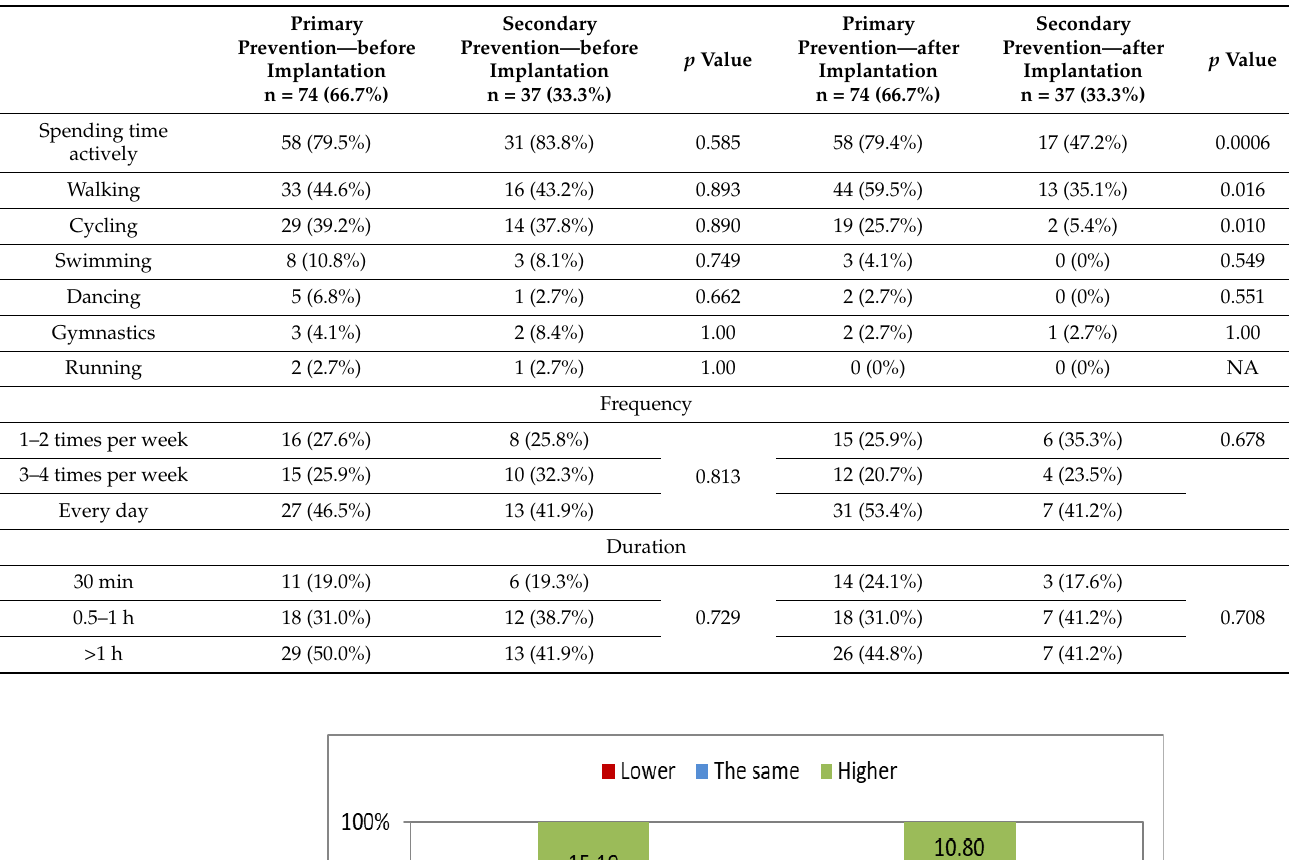
Table 3. Physical activity of patients before and after implantation, according to type of prevention.